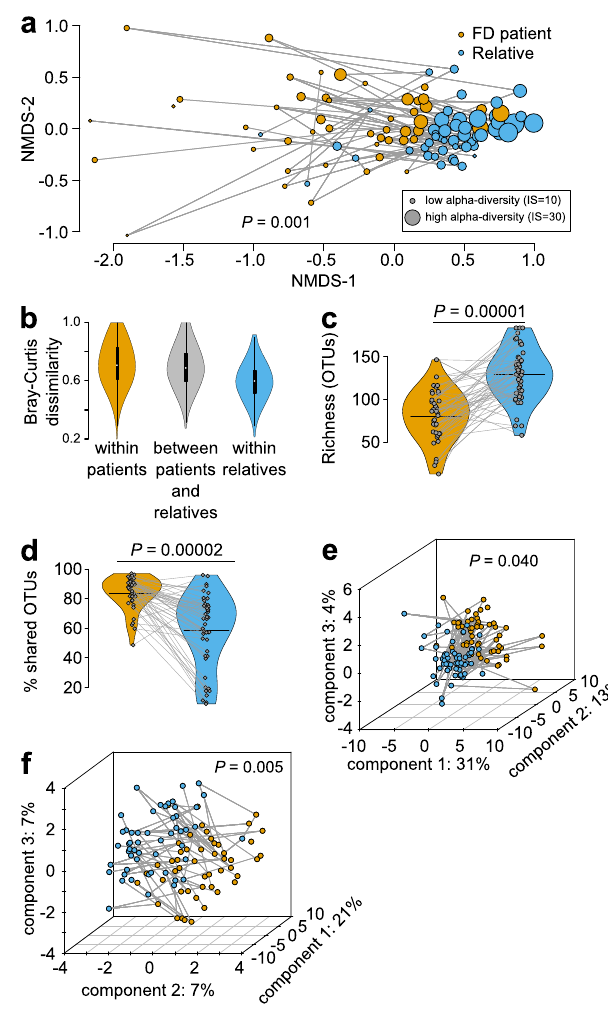
Fig. 1 | FD alters the microbiome and metabolome. a Non-metric multi- dimensional scaling (NMDS) of 16S rRNA-based stool microbiome diversity in FD patients and healthy relatives (all patient-relative pairs connected with lines). IS, inverse-Simpson ’ s index. b , Microbiome beta-diversity (Bray-Curtis dissimilarity) withinandbetweenFDpatientsandpairedrelatives(eachviolinplotcontainsabox and whisker plot here a white dot=median, box=interquartile range (IQR), whis- kers=1.5 times IQR). c , d , Microbiome richness ( c ) and percentage (%) of shared operational taxonomic units (OTUs) ( d ) between FD patient and healthy relatives (colors as in a ; bars=mean; lines connect patients and relatives). e , f Partial least- squares discriminant analysis (PLSDA) of 1 H-NMR-based stool ( e ) and serum ( f ) metabolome diversity in FD patients and healthy relatives (colors as in a , b ). n = a , b ,48patients,51relatives; c , d ,38patients,47relatives,47pairs; e ,54patient, 58 relatives; f , 49 patients, 53 relatives. PERMANOVA of Bray-Curtis dissimilarity ( a ,F=6.847,df=1,R 2 =0.066)orEuclideandistance( e ,F=2.153,df=1,R 2 =0.0191; f ,F=2.506,df=1,R 2 =0.0245);permutationalpairedt-testing,two-sided( c ,meant- statistic= − 5.423, df=29, mean difference between group means= − 45.114, mean 95% con fi dence interval of the difference between the group means= − 62.130 to − 28.100; d , mean t-statistic=5.220, df=29, mean difference between group means=24.944,mean95%con fi denceintervalofthedifferencebetweenthegroup means=15.16 to